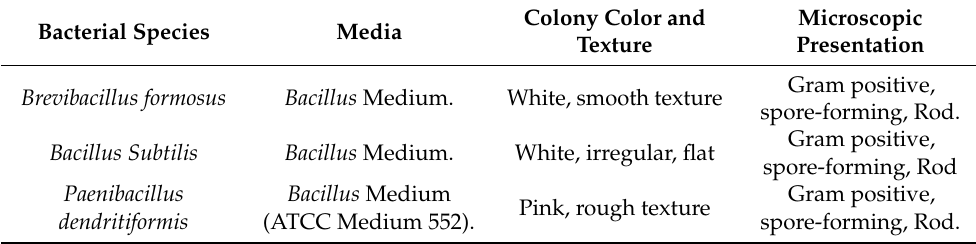
Table 1. Colony morphology and microscopic presentation of isolated bacterial species. Bacterial Species Media